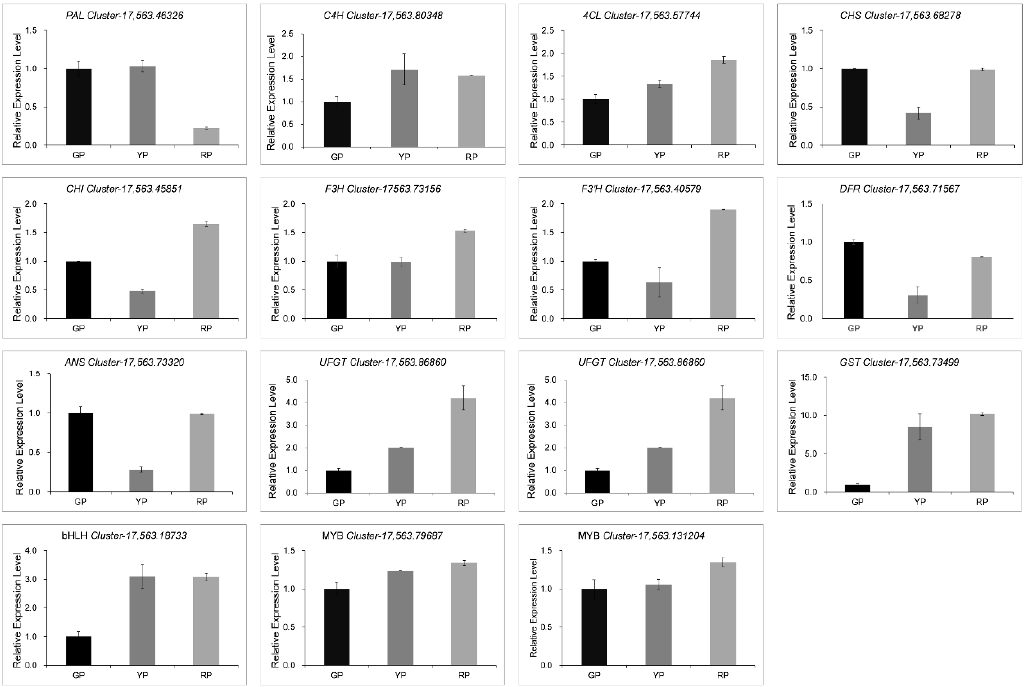
Figure 6. Analysis of the expression levels of key structural genes and transcription factors during anthocyanin biosynthesis in D. delavayi .